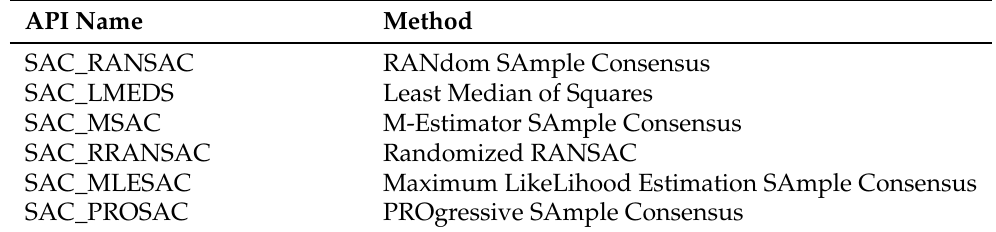
Table 2. List of sample consensus methods available in PCL (as of 1.12.1